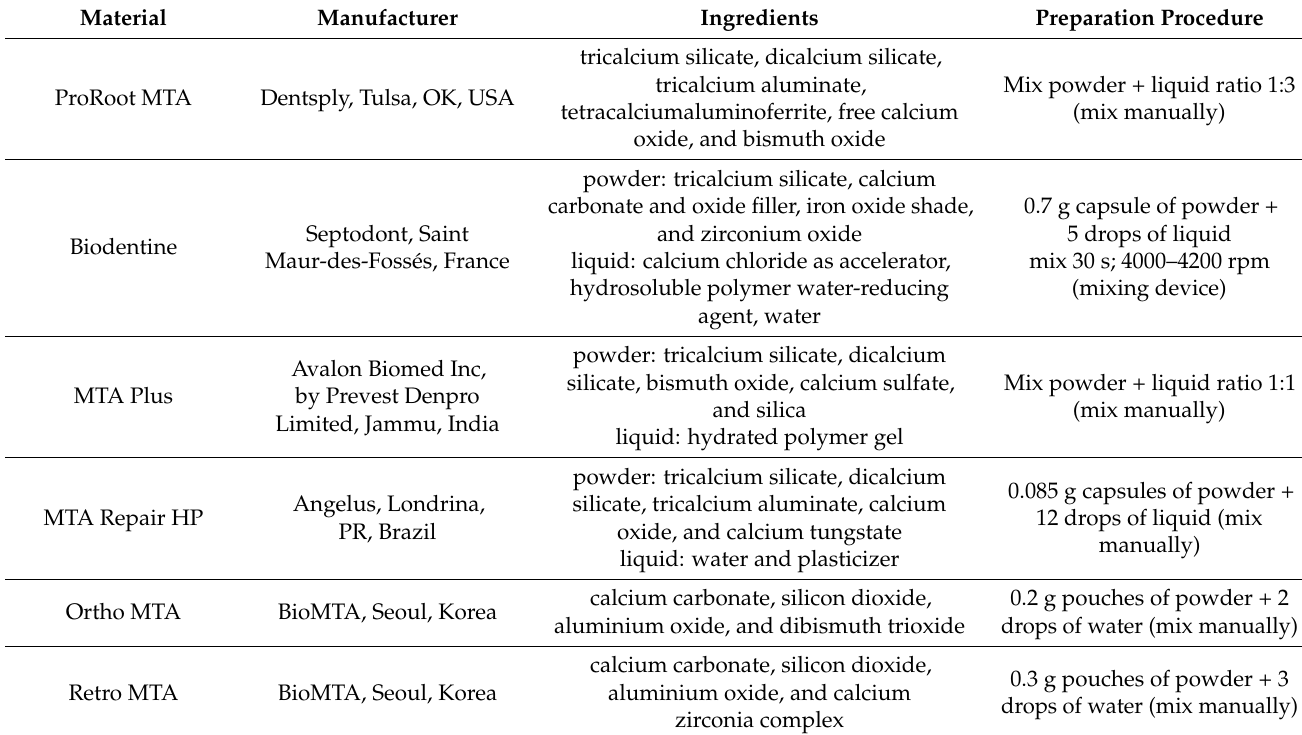
Table 1. Compositions of the CSCs considered in this